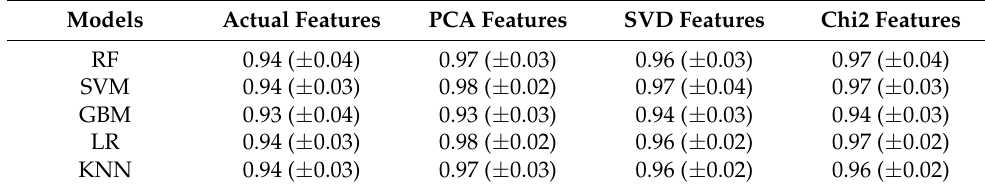
Table 13. k-Fold cross-validation by all feature selection techniques